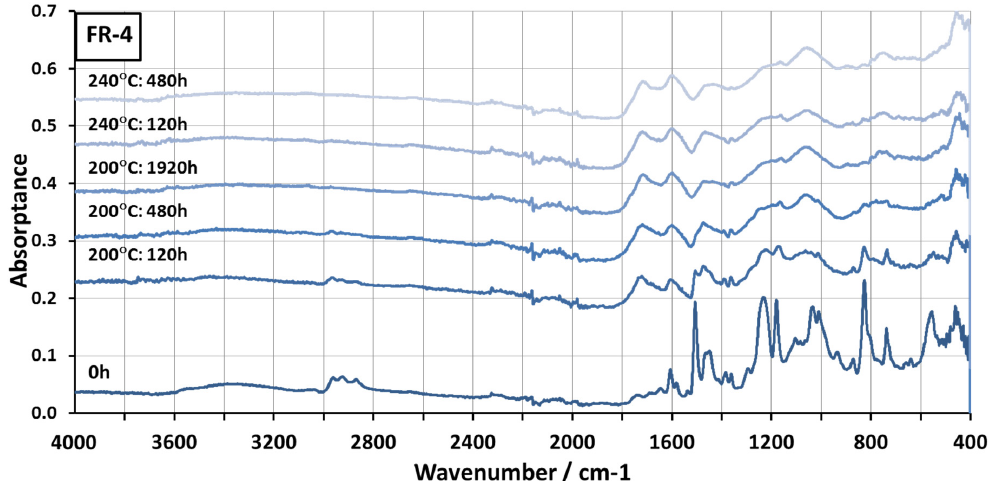
Figure 4. FTIR spectra of the High ‐ T g FR ‐ 4 PCB aged at 200 °C and at 240 °C.